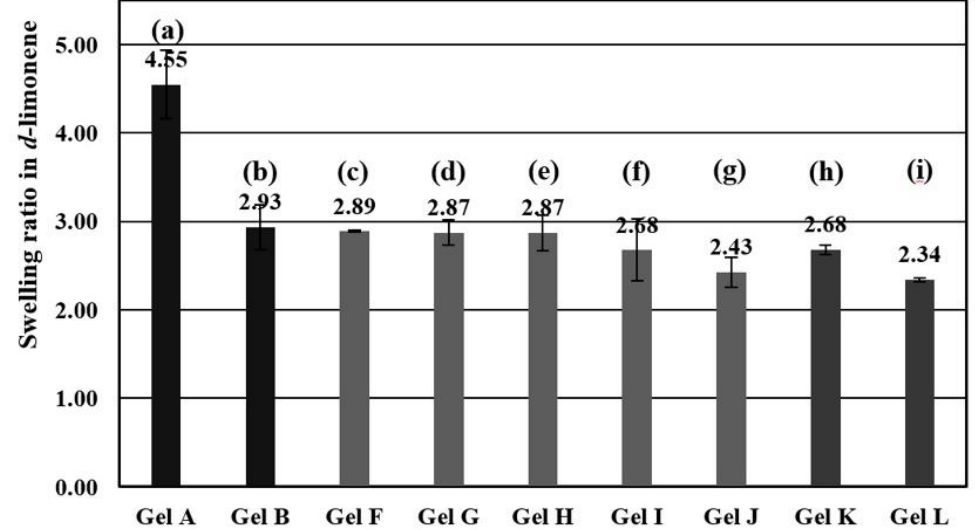
Figure 2. Swelling ratios of gel A ( a ), Gel B ( b ), Gel F ( c ), gel G ( d ), gel H ( e ), gel I ( f ), gel J ( g ), gel K ( h ) and gel L ( i ) ( n = 3, error bars present standard deviation).